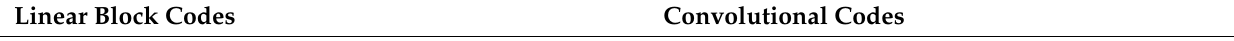
Table 1. The main differences between linear block codes and convolutional codes. Linear Block